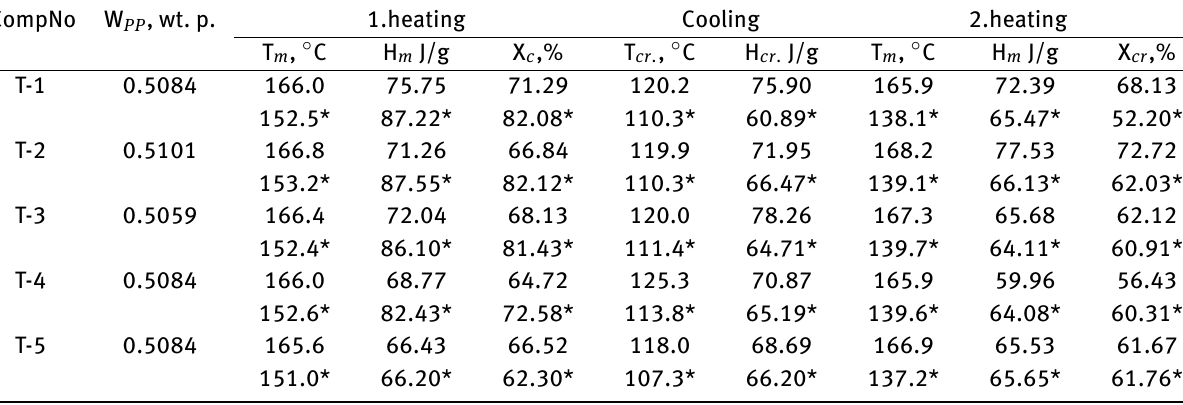
Table 3: The results of DSC mesurements of non-weathered and weathered* composites CompNo W PP , wt.